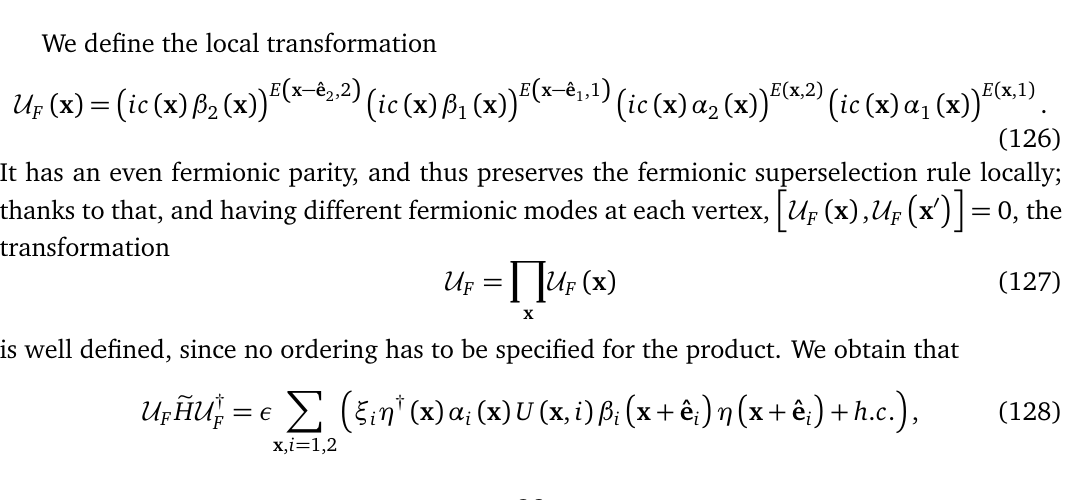
Figure 2: Pictorial representation of (124). The modes f direction i are formed by combining the modes α and β on the respective link. The auxiliary modes c ( x ) are depicted in blue as in Figure